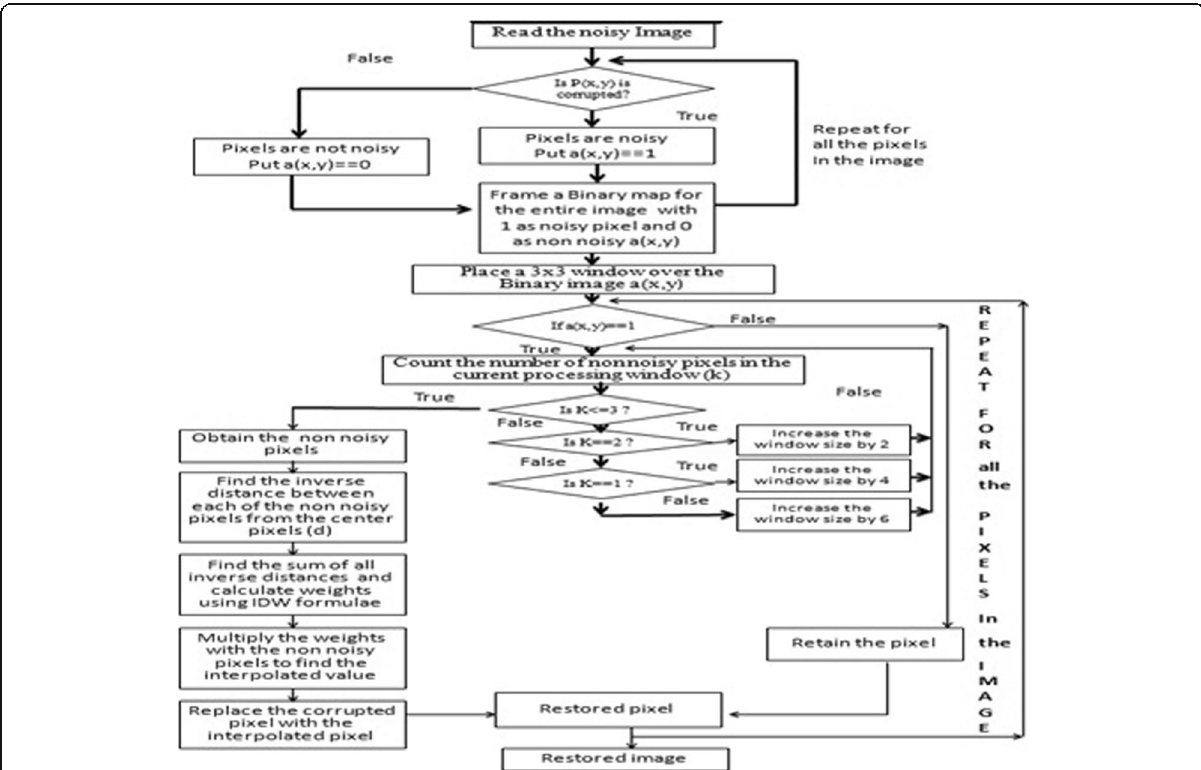
Fig. 1 Flowchart of the adaptive decision based Inverse distance weighted interpolation